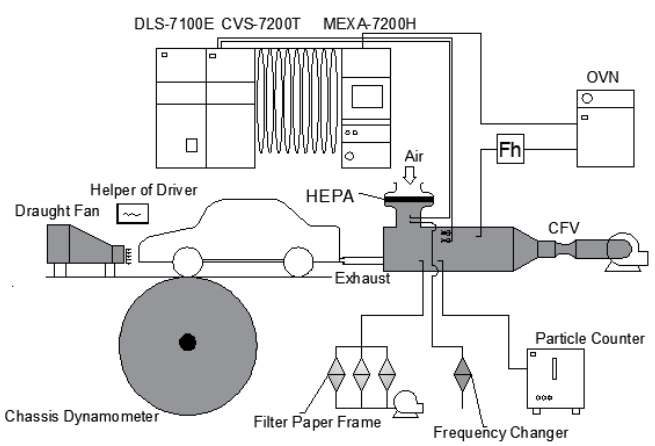
Figure 1. Schematic of the experimental setup. HEPA: High Efficiency Particulate Air filter; OVN: Oven Type Heated Analyzer; CFV: Critical Flow Venturi.